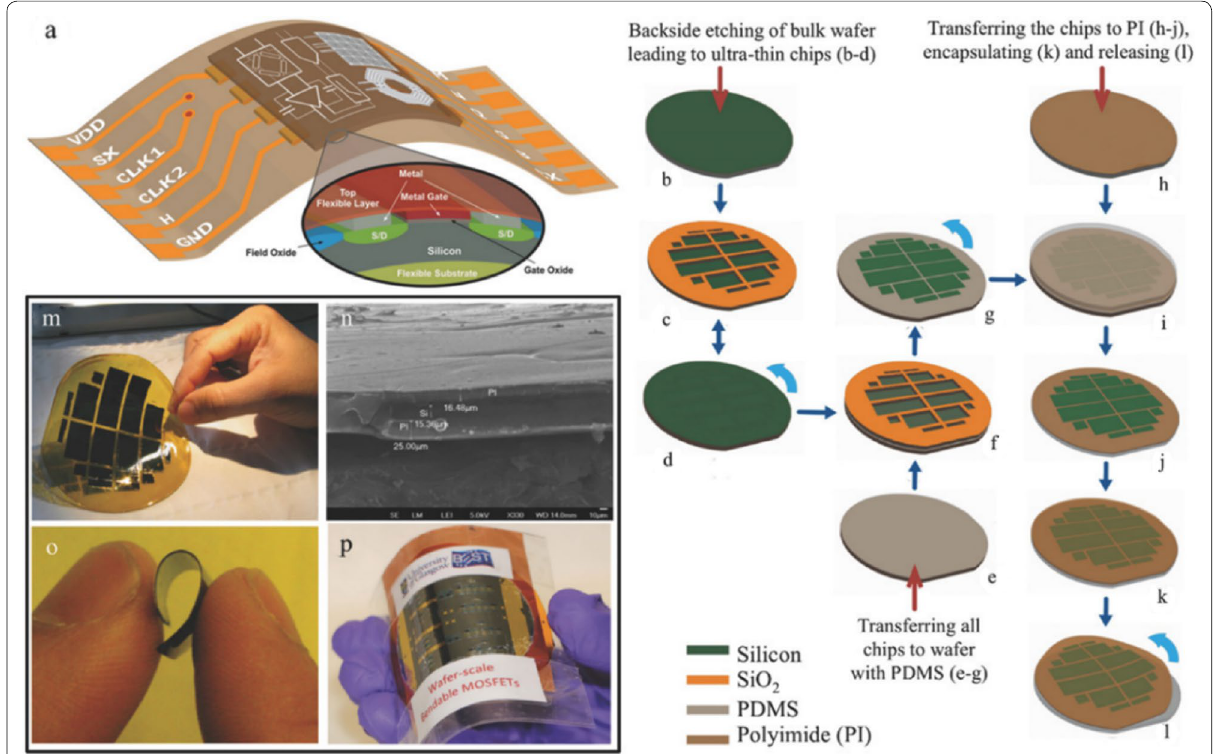
Fig. 7 a – p The process flow of fabrication and transfer of UTCs on to the flexible polyimide substrate through backside chemical etching and PDMS assisted-wafer scale transfer process, respectively. Reprinted with permission from Ref [26]. Copyright (2018) WILEY. a Schematic illustration of integrated multilateral stack on flexible substrate. Schematic illustration of backside etching of bulk wafer to UTCs with ( b ) initial bulk wafer, ( c ) back side of UTCs membrane with selective thermal oxide hard mask, and ( d ) the front side. Transfer printing process with two stages: “Stage 1” transferring to carrier substrate with schematic illustration of ( e ) PDMS spin-coated temporary second wafer, ( f ) attaching the UTCs to PDMS, and ( g ) lacer cutting to remove the bulk silicon; “Stage 2” transferring to receiver substrate with schematic illustration of ( h ) polyimide spin-coated on temporary third wafer, ( i ) transfer the UTCs on top of polyimide, ( j ) chemical etching of PDMS and remove the second temporary wafer to expose the top surface, ( k ) spin-coating polyimide to encapsulate the UTCs and ( l ) releasing the temporary third wafer to obtain encapsulated UTCs. m Digital image of flexible UTCs transferred on polyimide and ( n ) cross sectional SEM image of UTCs. The photographic image of ( o ) flexible UTCs and ( p ) the n-MOSFET device encapsulated by